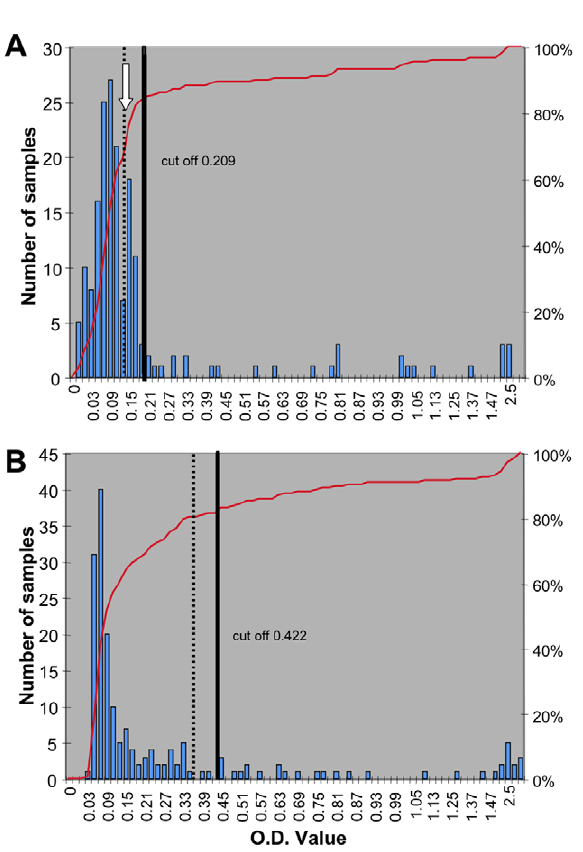
Figure 2. Comparison of results of testing with IgG ELISA kits. A) Wantai kit B) Dia.Pro test. Number of samples per OD value class (blue bars); red line: cumulative % of value: 100% is the 180 tested samples. Negative control value is given by a vertical doted line and the cut-off value as determined for the kit is given by a vertical continuous line. Arrows in the Wantai graph (A) indicate the OD values for a group of people with sub-detectable IgG.